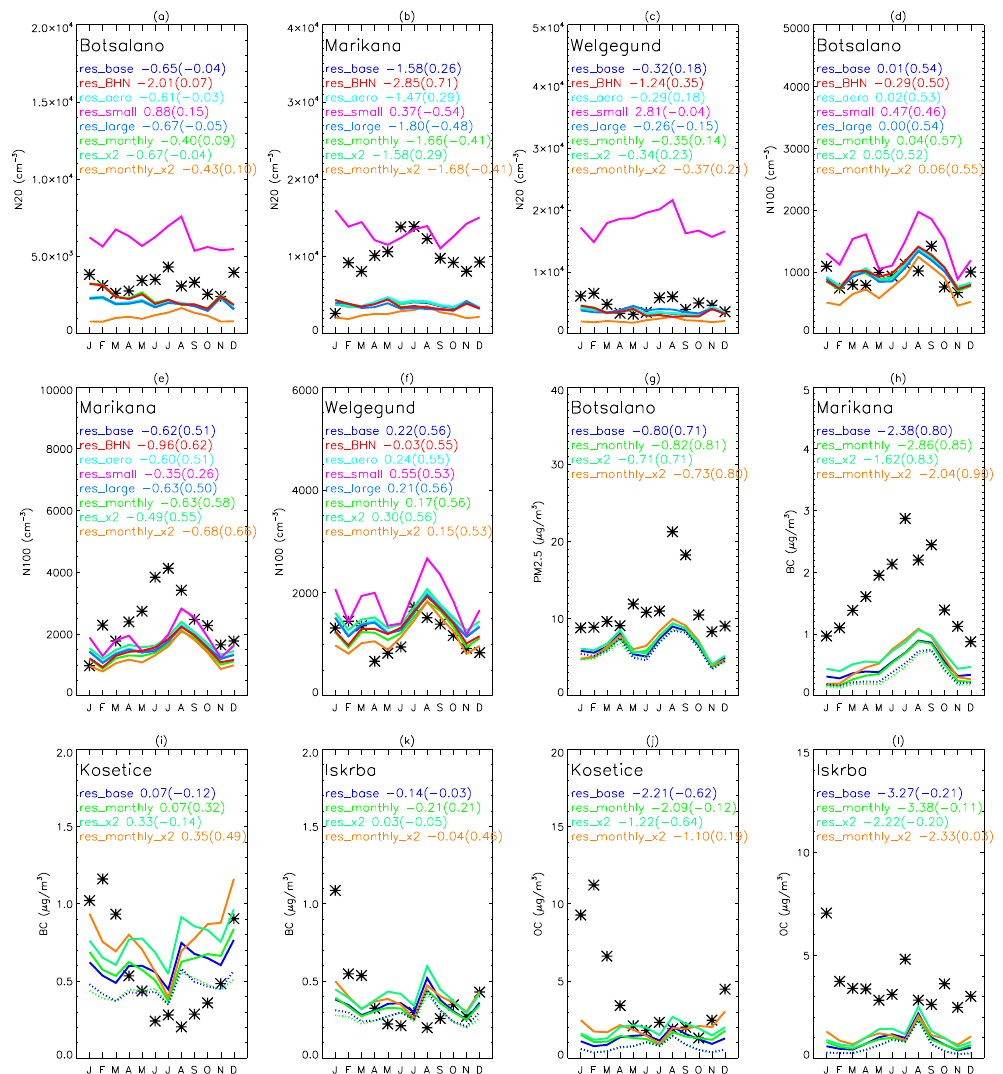
Figure 6. Observed (black stars) and simulated monthly mean N 20 (a–c) , N 100 (d–f) , PM 2 . 5 (g) , BC (h–k) , and OC (j–l) at South African and Eastern European locations. Normalised mean bias factor (NMBF) and correlation coefficient ( r ) are reported for each model sim- ulation: NMBF (r) . Experiments where residential emissions have been removed are represented by the blue (res_base_off) and green (res_monthly_off) dotted lines. Note that additional experiments (res_BHN, res_aero, res_small, and res_large) are included in (a) – (f) be- cause these experiments have little impact on aerosol mass (g–i)